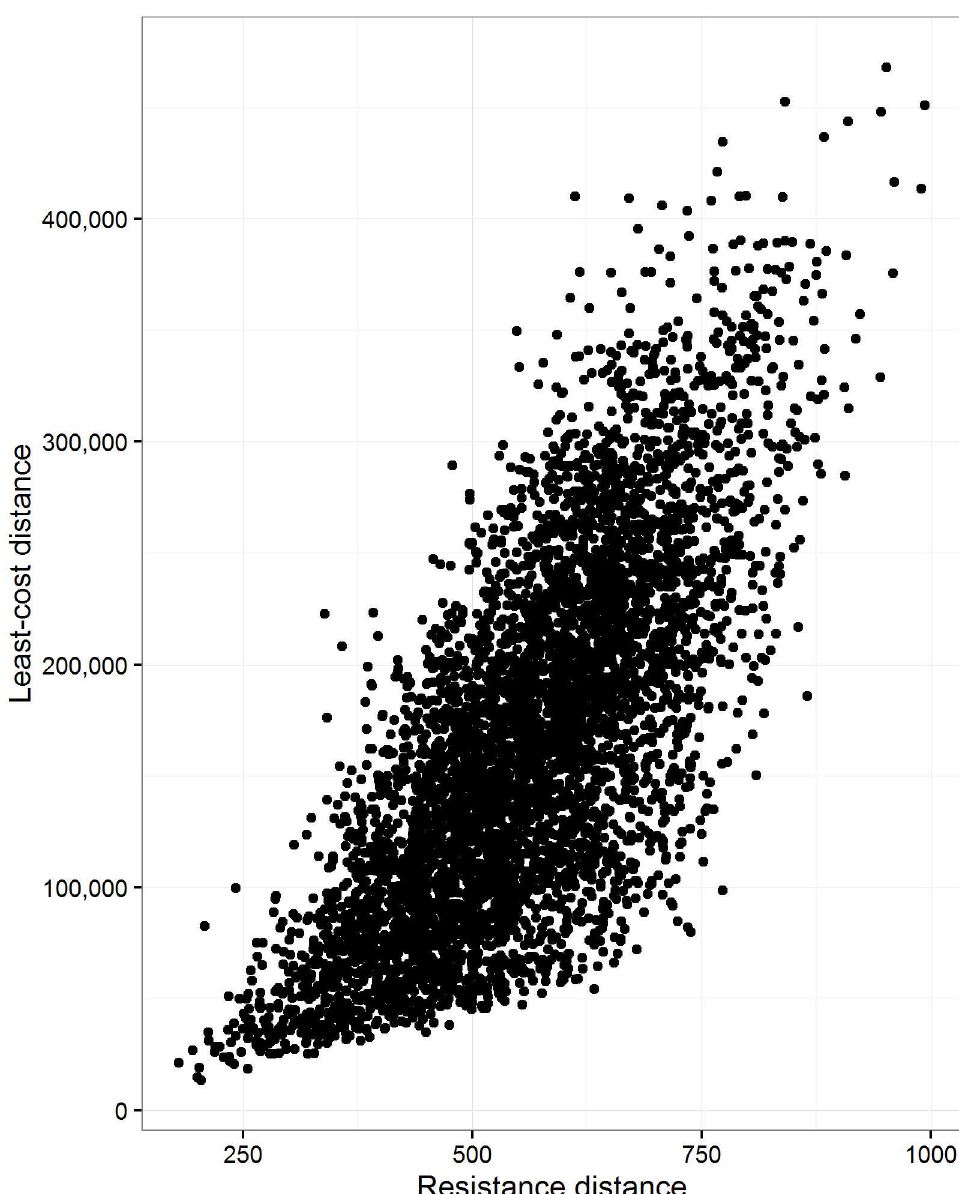
Fig 2. The relationship between least-cost and resistance distance. The relationshipbetweenleast-cost and resistancedistancefor a subset of 5,000 randompairs sampledfrom 1000 different simulatedlandscapes ( p = 0.731). We had to randomlysubset the data to make the figures more visuallyappealing,since there were 105,000actual points. Landscapesize (number of pixels) was held constant at